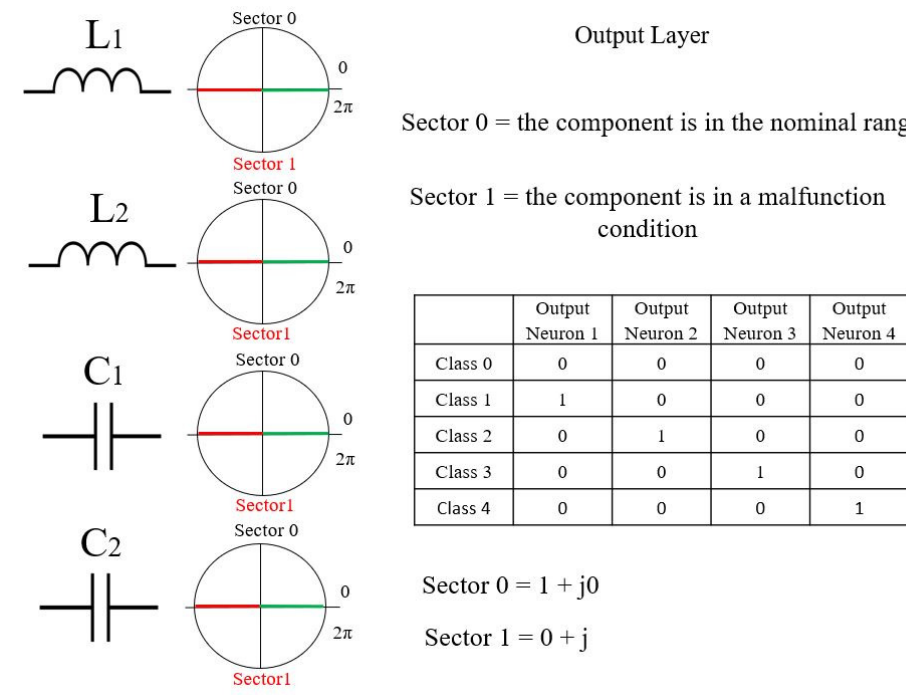
Figure 5. Set-up of the output layer and coding of the classes. When, for example, only the first output neuron is “high”, the first fault class is identified, which means that a problem is detected on L 1 . This rule is used for classes 1 to 4, while class 0 corresponds to a “low” value on each output neuron. It is necessary to highlight that the “winner take all” technique is used to avoid the presence of two outputs on the “high” value at the same time. This means that only the minor error output is considered equal to 1. Formula (14) describes the dataset matrix introducing the coding of the fault classes.